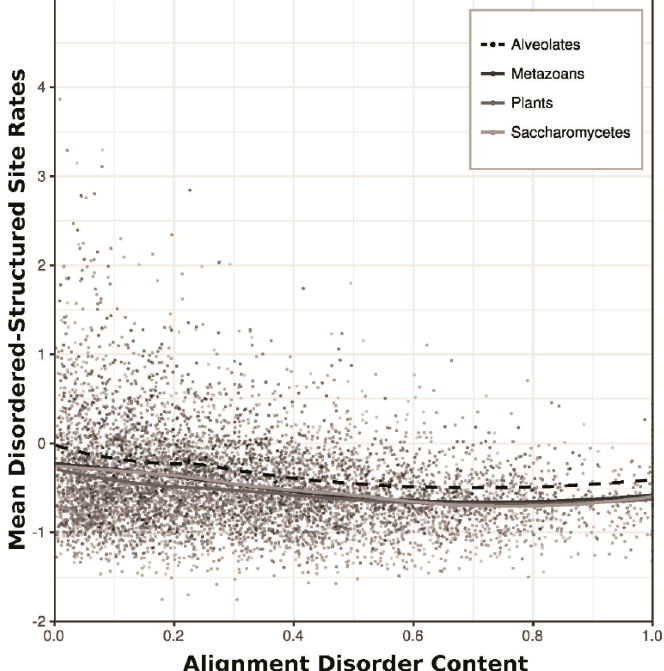
Figure 4. Scatterplot showing the disorder content of clusters (fraction of disordered alignment sites) against the mean rate of sequence evolution among sites predicted to be both disordered and structured. Only sequence clusters containing disordered/structured sites are shown. Trend lines were constructed for each of the four eukaryotic datasets using Loess regression. Note that the Alveolate trend line (dashed) is consistently higher than other